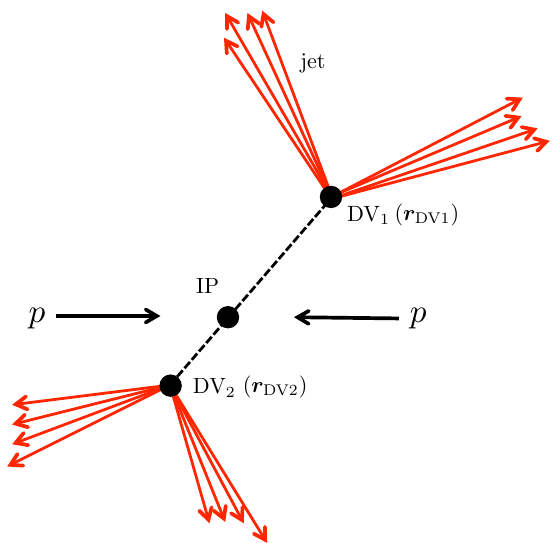
Figure 1. The event topology of metastable gluino decay. Here, DV vertices of gluino, while IP is the interaction